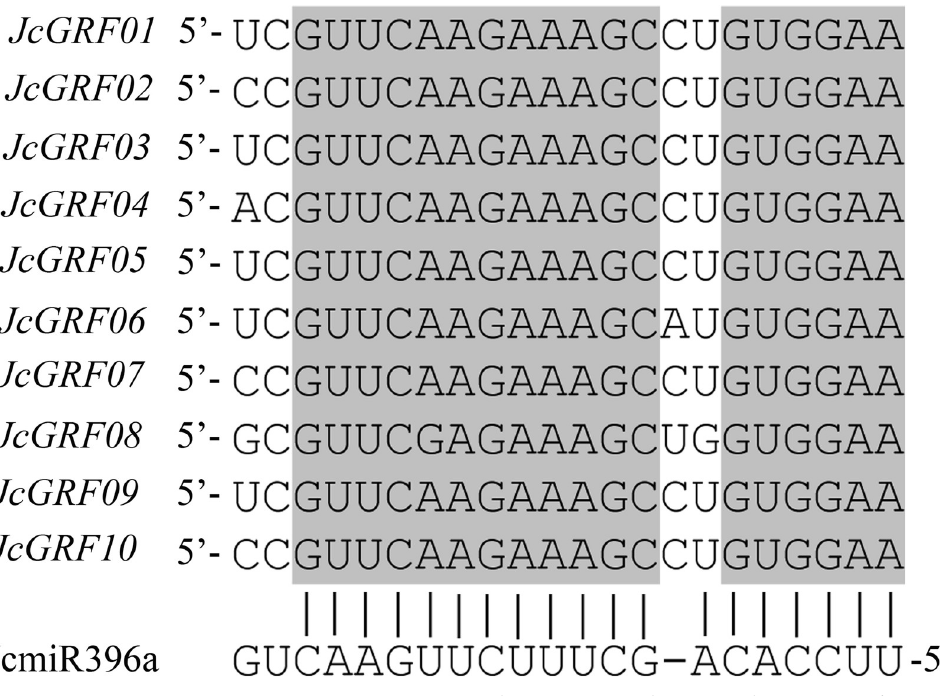
Fig 5. miR396a can target JcGRF genes. Diagram representing the JcGRF genes and miR396a. The interaction of 10 miR396a-regulated JcGRFs from Jatropha curcas with miR396a is indicated.